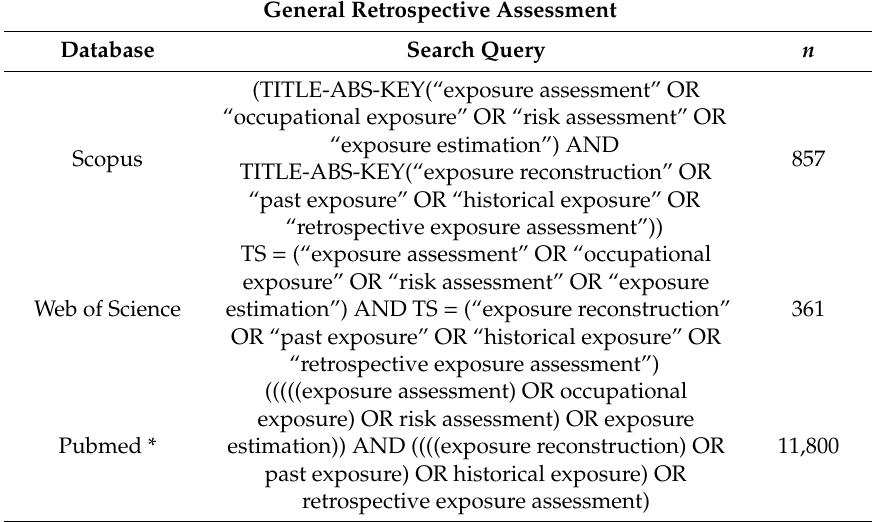
Table 1. Query used for the retrospective exposure assessment (REA) in general. N: number of papers results from the search. Date of search: 18 May 2020.